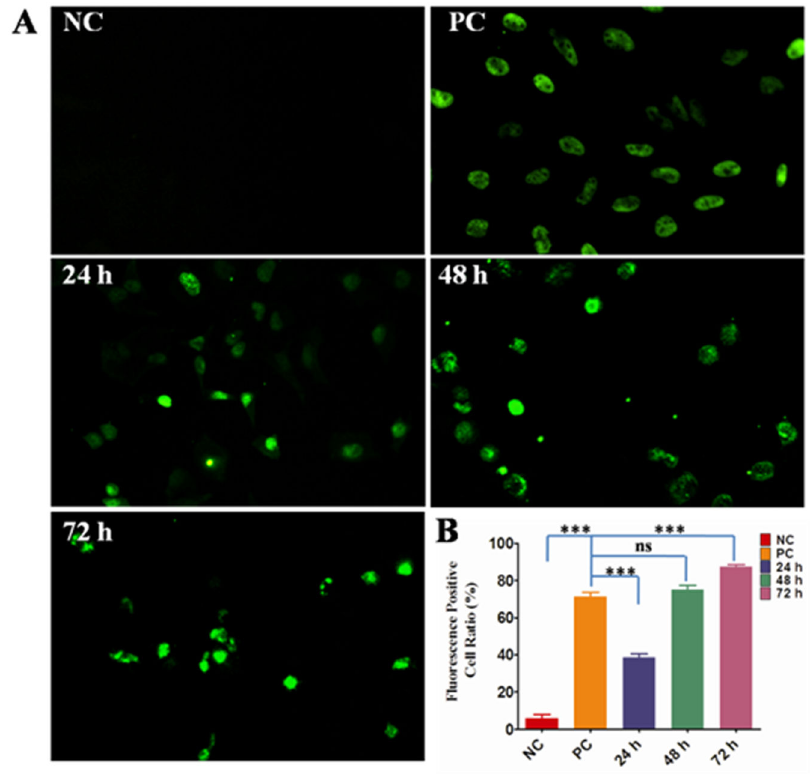
Figure 10. TUNEL assay with Hela cells to detect the oligonucleosomal DNA cleavage during cell apoptosis induced by [(dmb) Ru(obip)Ru(dmb) ] 4+ . A) The representative green fluorescence images taken under microscope after treatment with 2 2 [(dmb) Ru(obip)Ru(dmb) ] 4+ at MTT IC = 120 nM at different time points, B) the percentage of green fluorescence positive cells after 2 2 50 [(dmb) Ru(obip)Ru(dmb) ] 4+ treatment in comparison with both the negative and positive controls. NC means the untreated Hela 2 2 cells used as the negative control, PC means Hela cells treated with DNase I recombinant (3000U/ml-3U/ml in 50 mM Tris-HCl, PH 7.5, 1 mg/ml BSA) for 10 min at 15-25 °C used as the positive control. 24 h, 48 h and 72 h mean Hela cells treated with [(dmb) Ru(obip)Ru(dmb) ] 4+ for 24 h, 48 h and 72 h respectively before labelling. Scale bar 25 um. Data were presented as 2 2